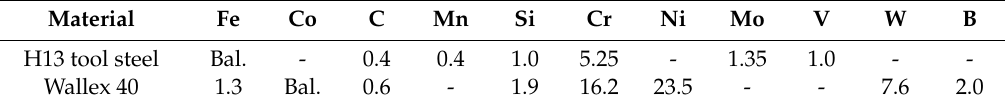
Table 3. Chemical composition of the materials (wt %).